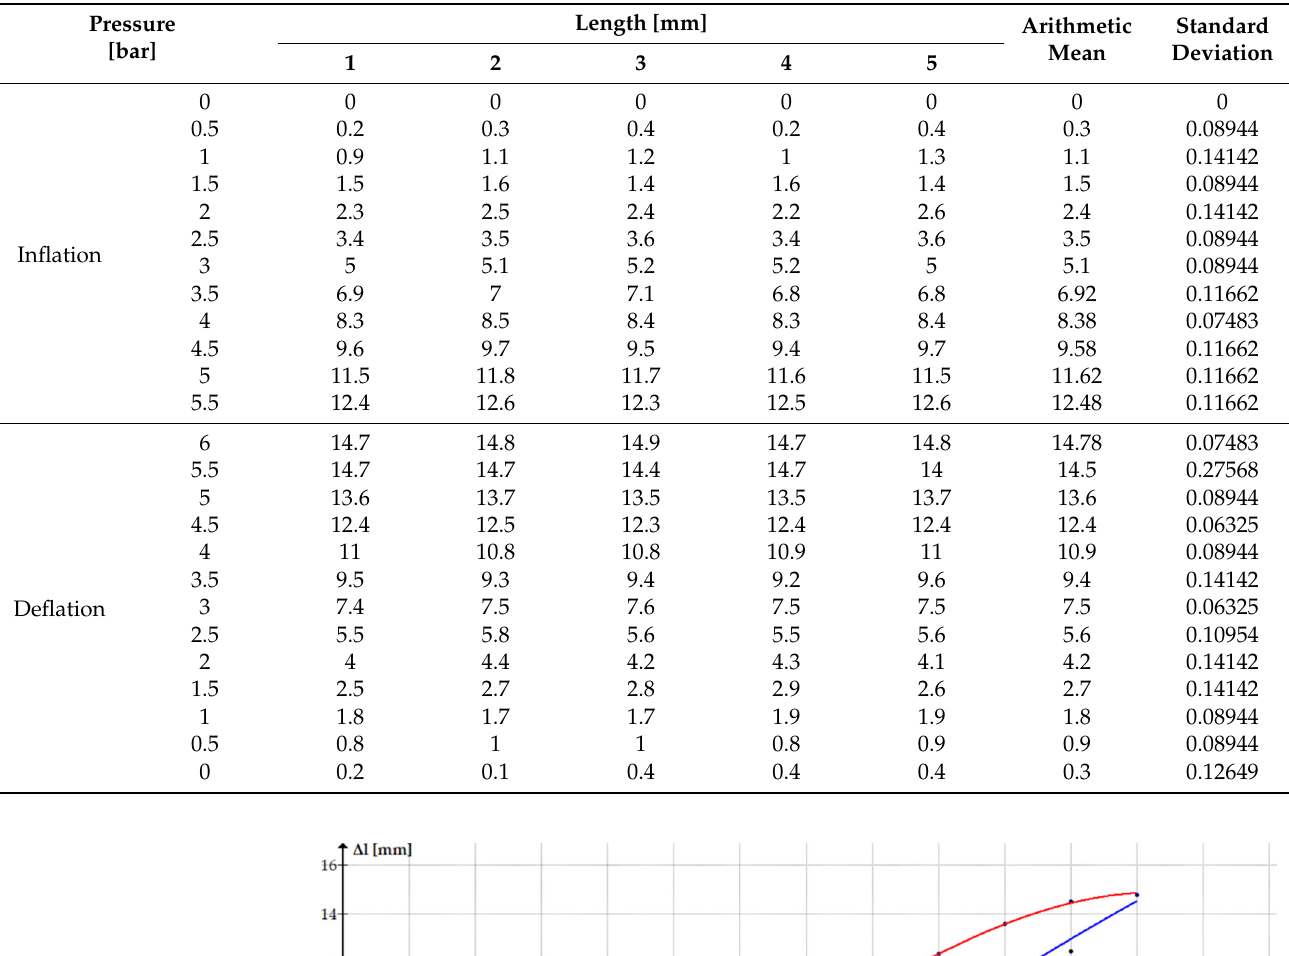
Table 4. Muscle axial contraction for a 2.55 kg external load.